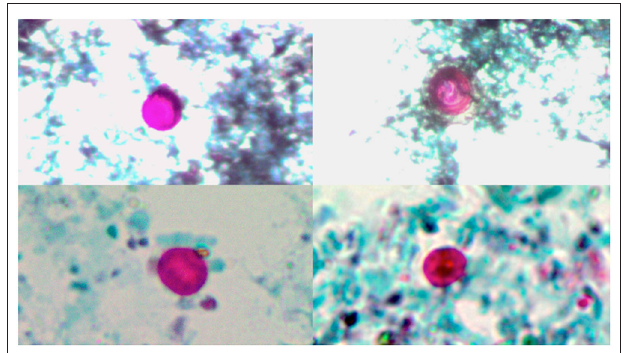
FIGURE 1 | Fecal smears showing Cryptosporidium oocysts stained by modified Ziehl–Neelsen (1000X).